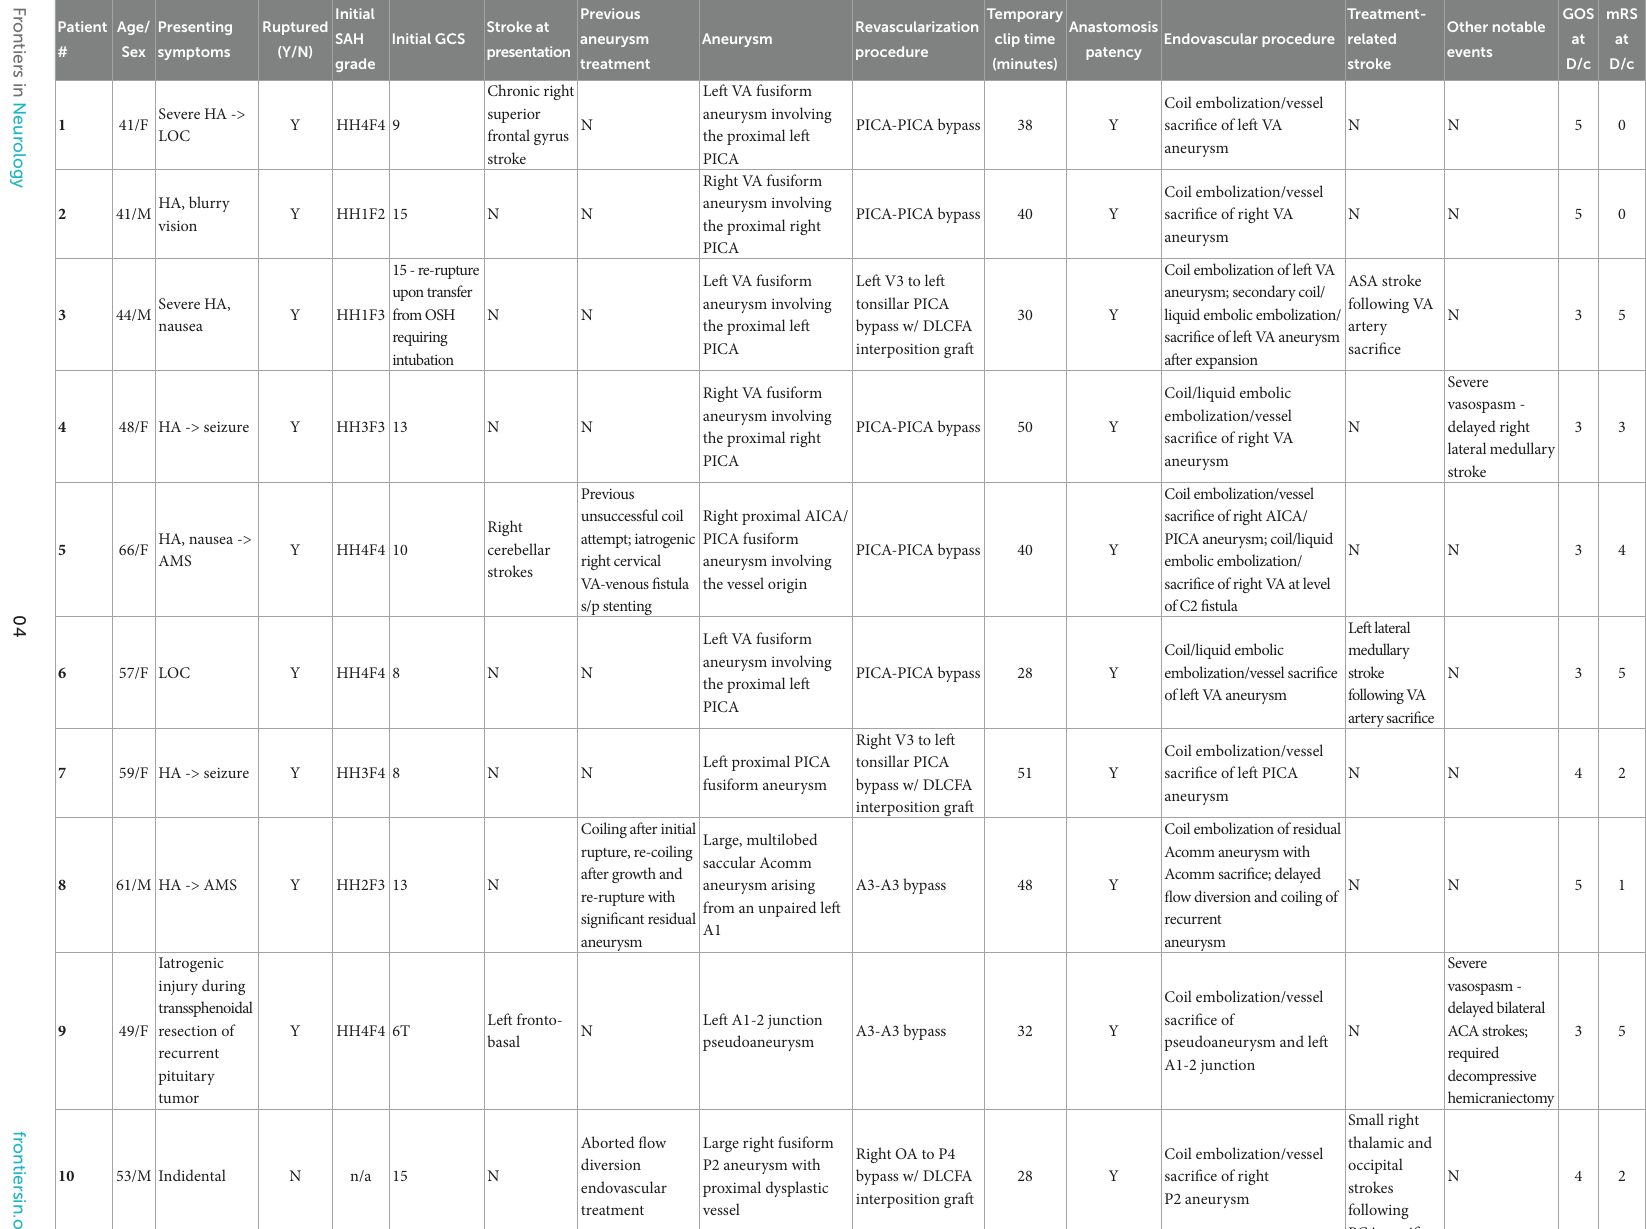
TABLE 1 Patient